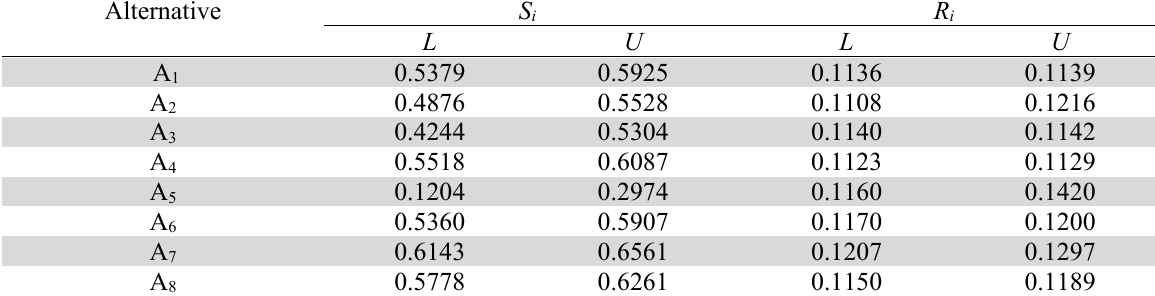
S i and R i values for interval VIKOR method Alternative